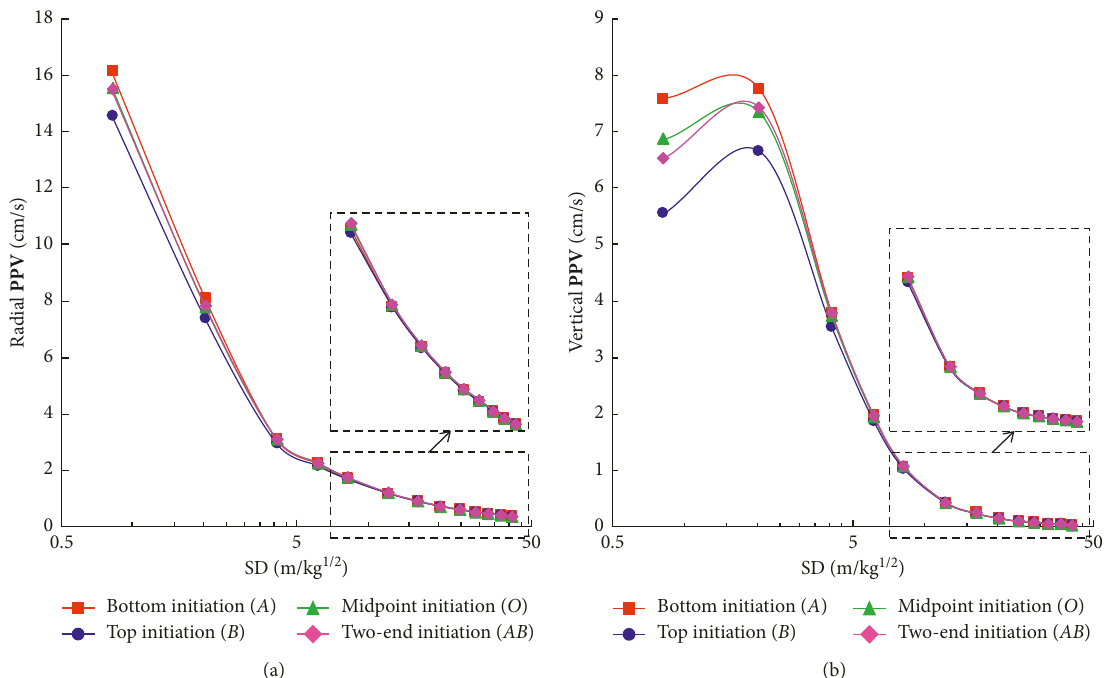
Figure 13: Comparison of PPV s observed along the radial direction of the cylindrical charge. (a) Radial PPV . (b) Vertical PPV .